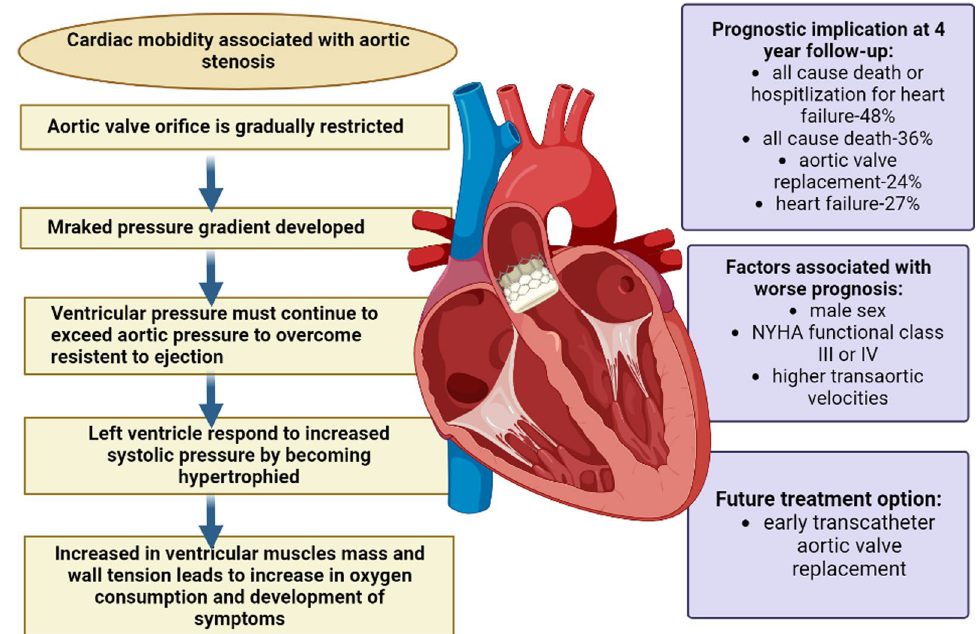
Fig. 4 Cardiac morbidity associated with aortic